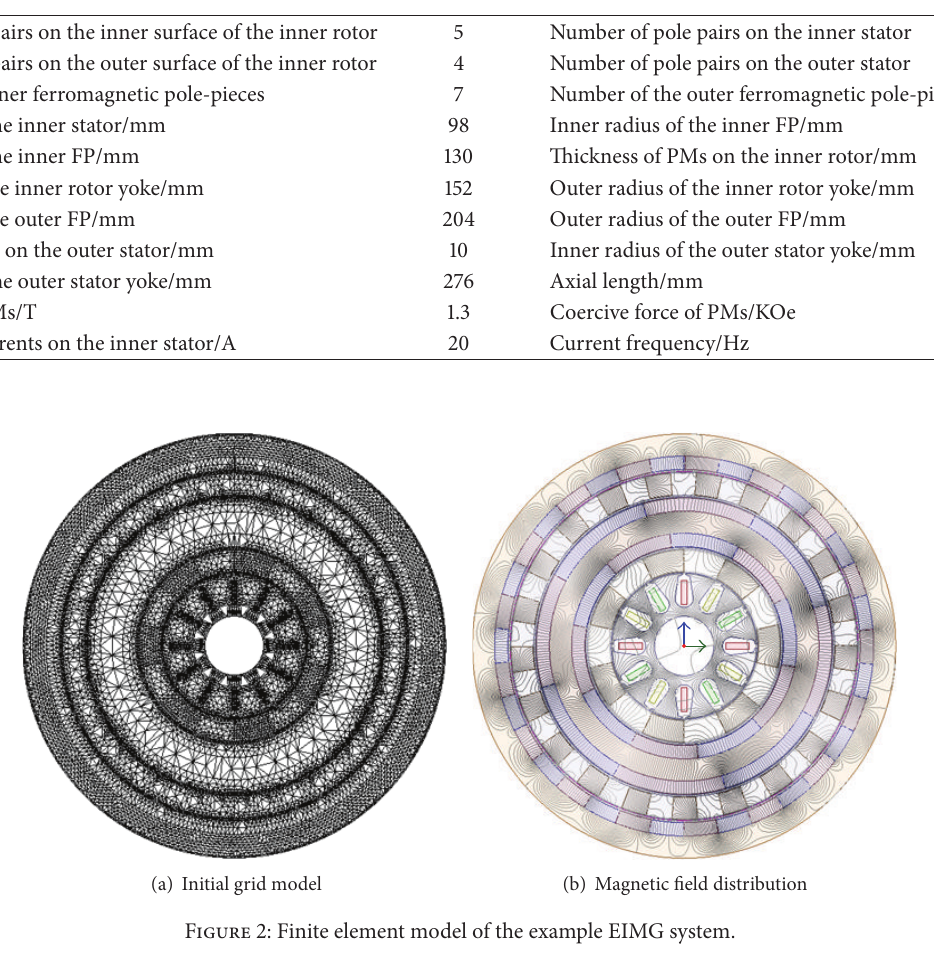
Table 1: Parameters of example EIMG system.